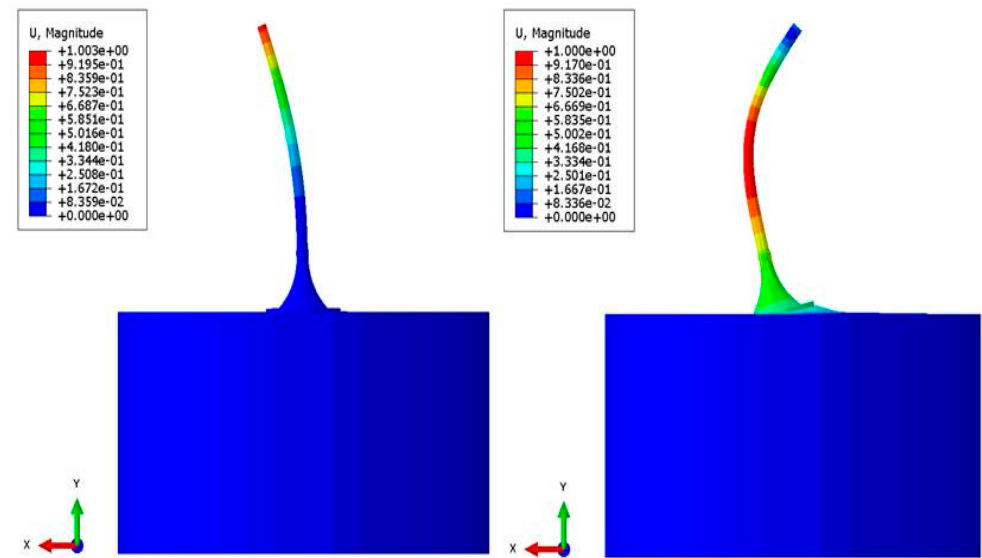
Figure 4. The first two mode shapes obtained from the modal analysis.